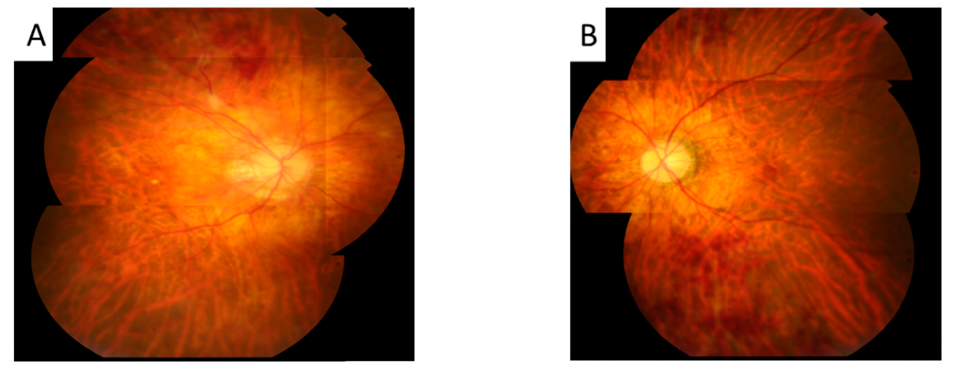
Figure 1. The color photos showed mid vitritis, retinal exudates, and hemorrhage in right eye ( A ) and left eye ( B ) both eyes.